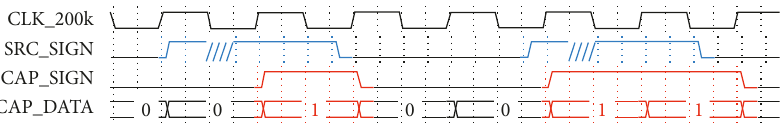
Figure 10: IR signal sampling with 200kHz sampling